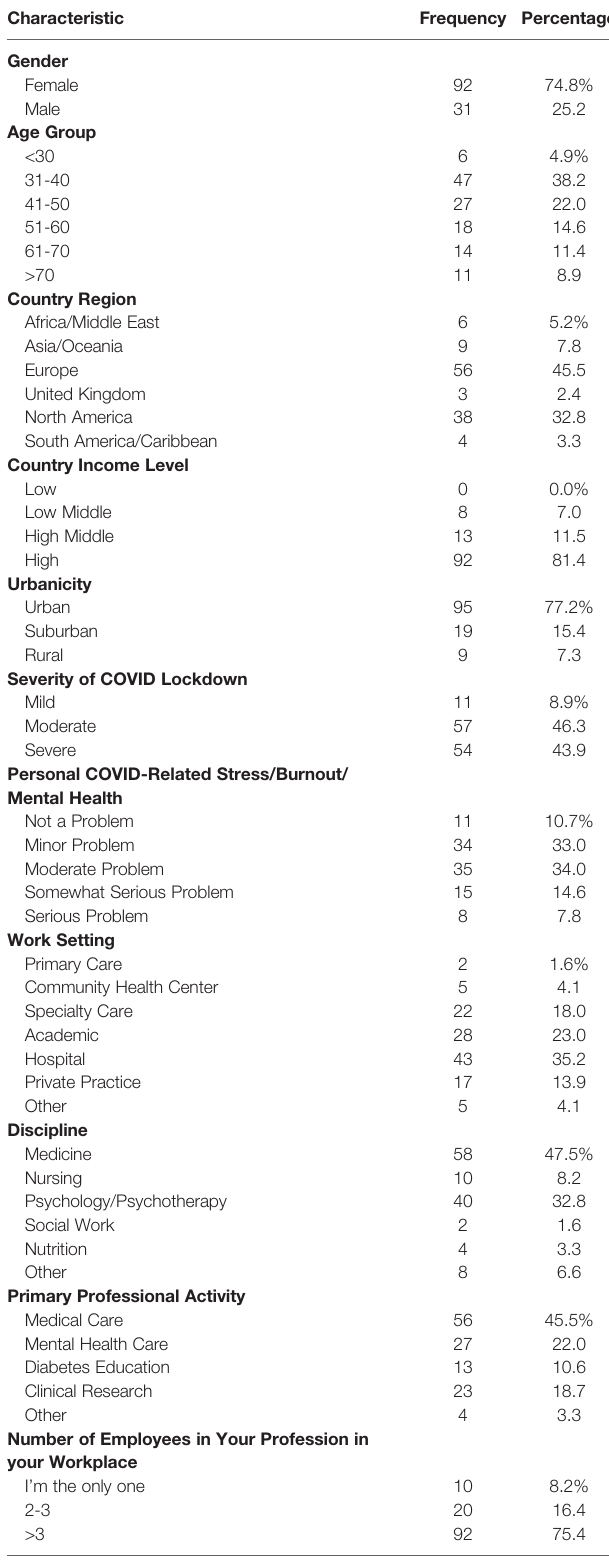
TABLE 1 | Demographic characteristics of respondents